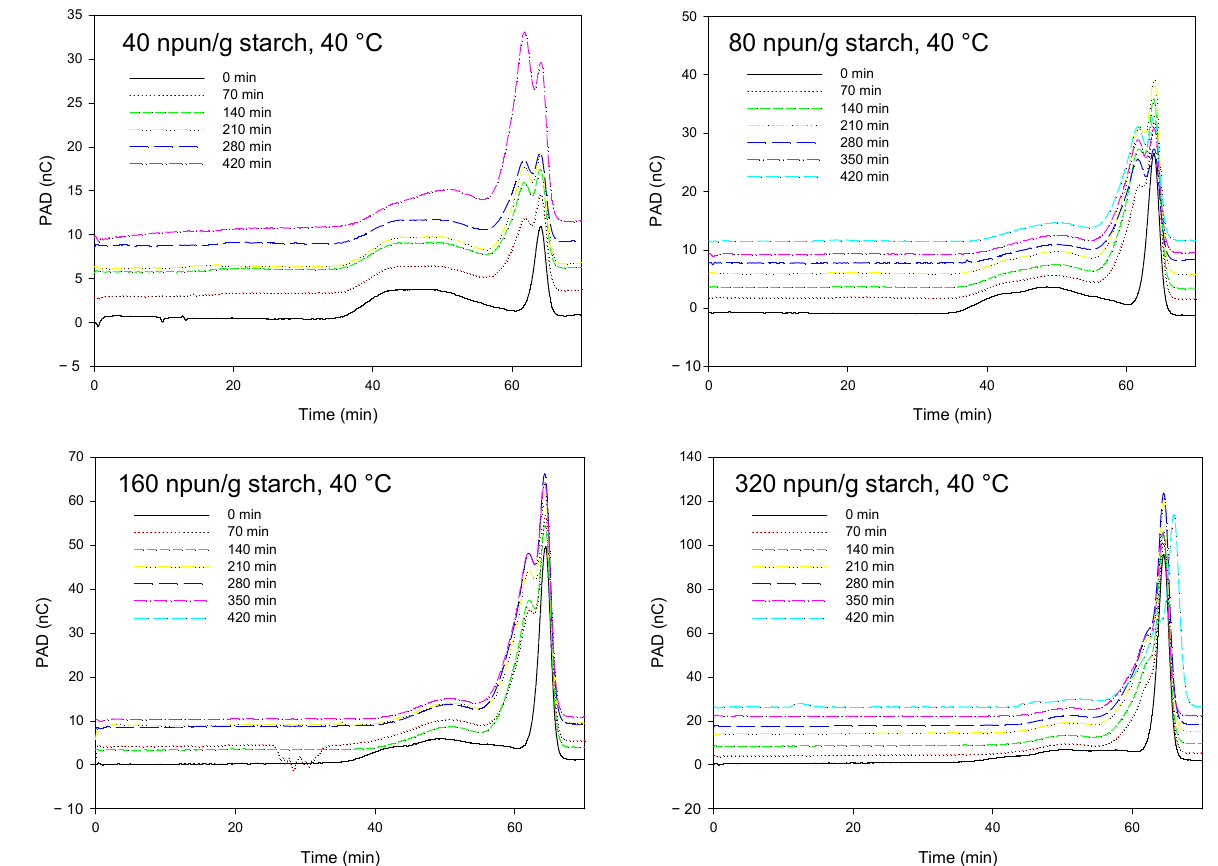
Figure 7. SEC-PAD chromatograms of the starch enzymatic hydrolysis kinetics with different con- centrations of Pullulanase.